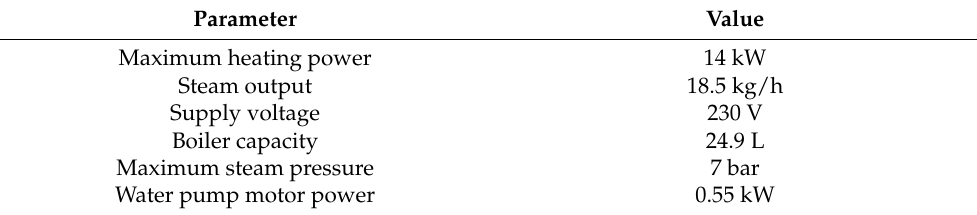
Table 2. Technical parameters of the steam generator MAXI 24.